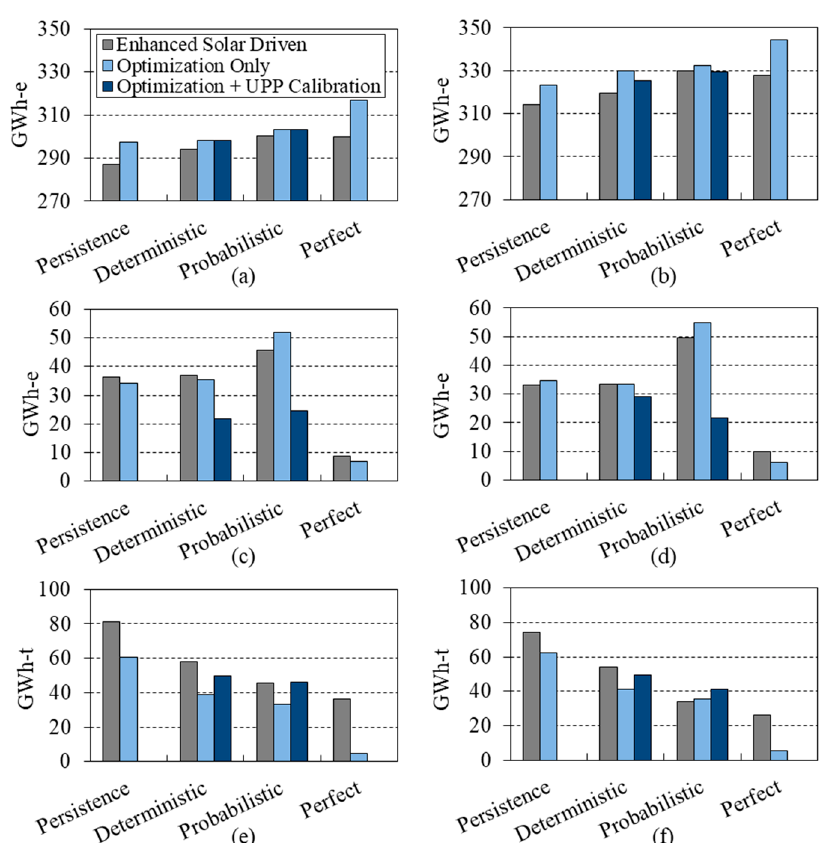
Figure 14. Total electricity delivered to the grid for 2016 ( a ) and 2017 ( b ), total electricity scheduled but not delivered for 2016 ( c ) and 2017 ( d ) and total thermal energy dumped by the solar field for 2016 ( e ) and 2017 ( f ), considering different dispatching strategies.